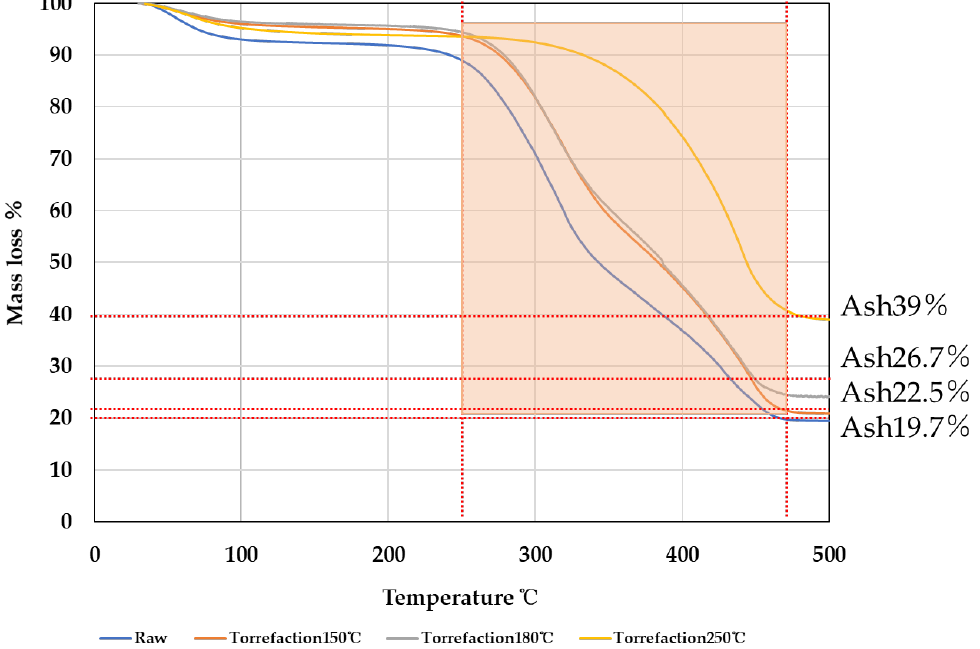
Figure 13. TG analysis results of the rice husk torrefaction products.